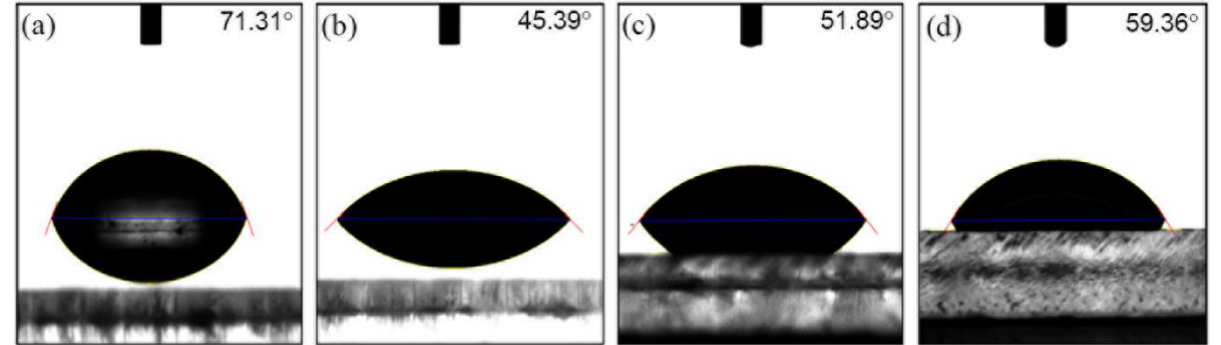
Figure 4. Water drops and contact angles on PMMA surface for different storage times: ( a ) for pristine: 71.31°, ( b ) right after UV exposure of 6 J/cm 2 : 45.39°, ( c ) 24 h after UV exposure of 6 J/cm 2 : 51.89°, ( d ) 30 days after UV exposure of 6 J/cm 2 : 59.36°. Table 1. Water contact angle of PMMA for non-rinsing samples after UV exposure.